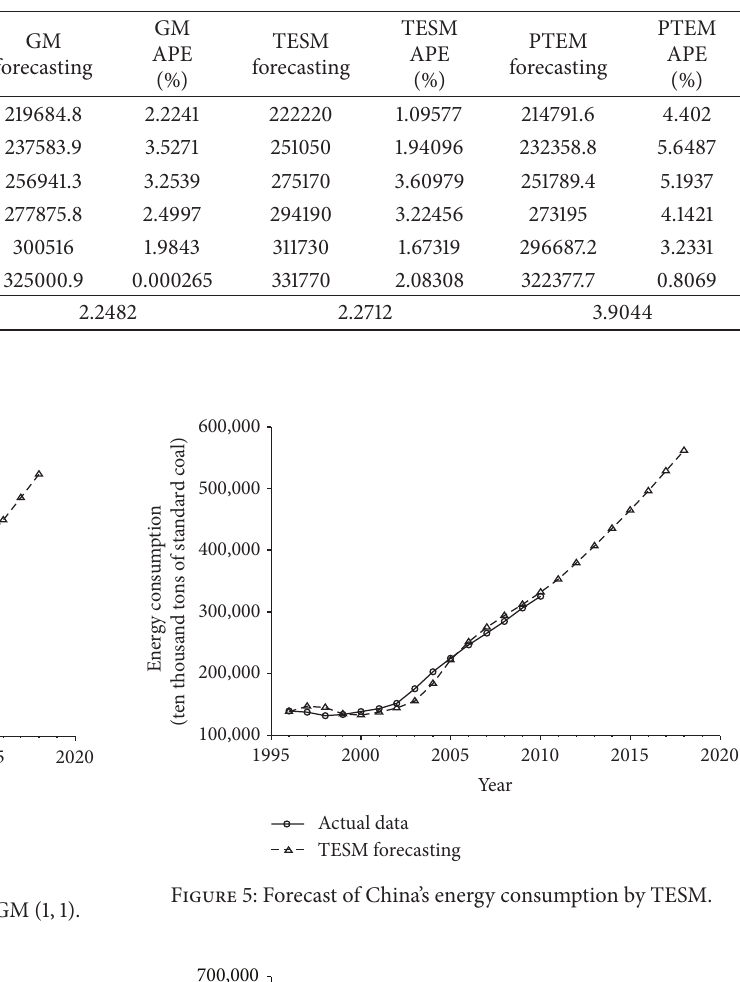
Table 1: Forecasting results of China’s energy consumption based on individual model in 2005 ∼ 2010.